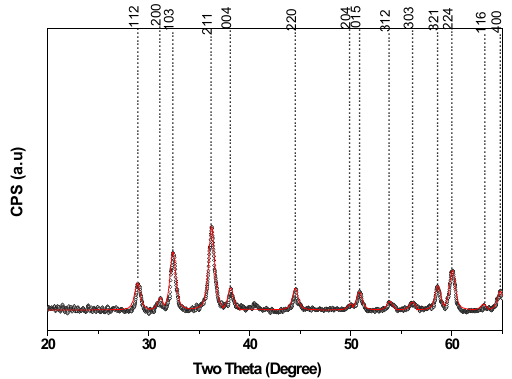
Figure 1. X-ray powder diffraction pattern (dots) and line profile fitting (solid line) for sonochemically synthesized Mn